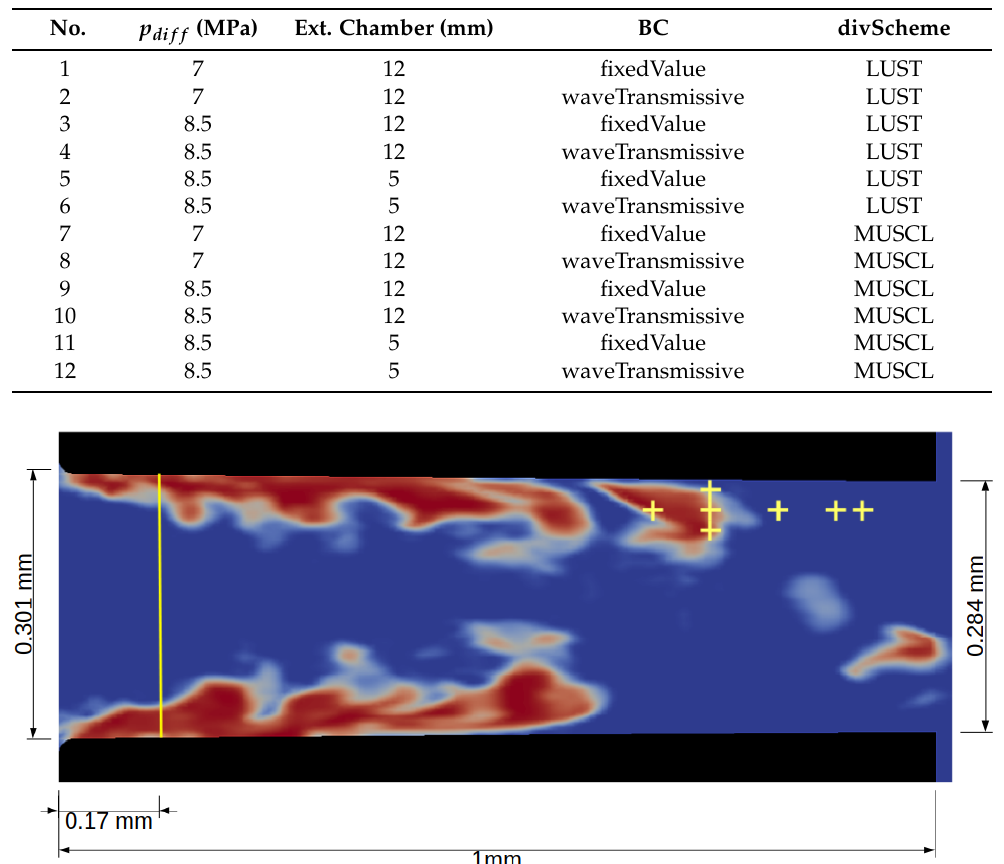
Table 1. List of test cases.